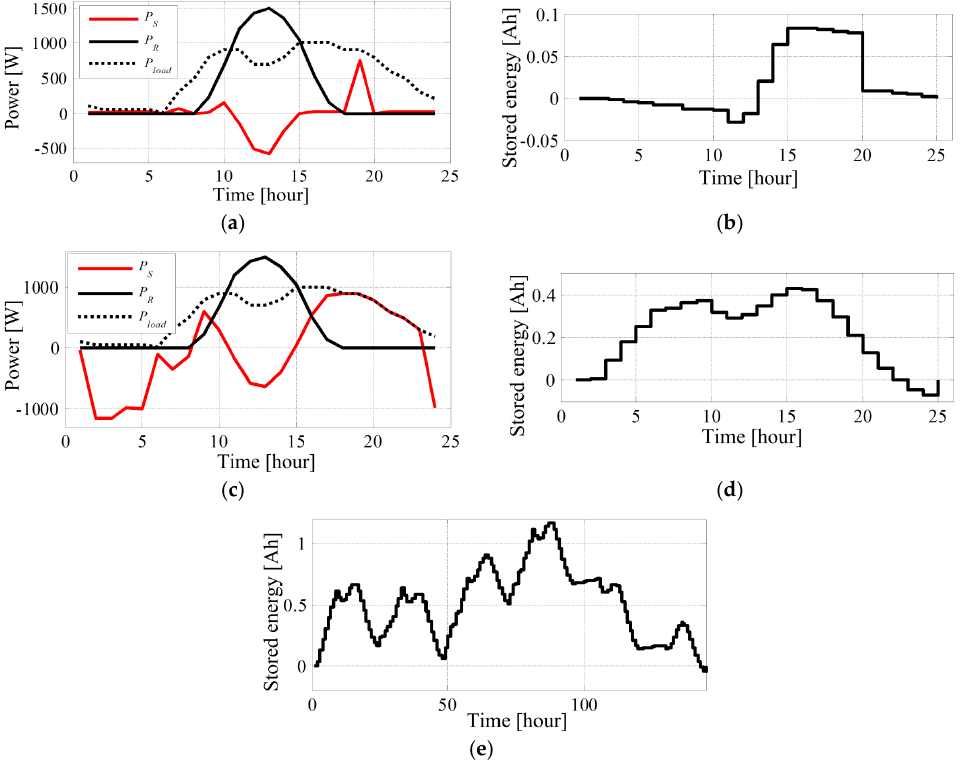
Figure 5. EMS optimization results with various conditions. ( a ) Power profile with fixed price; ( b ) energy profile with fixed price; ( c ) power profile with variable price; ( d ) energy profile with variable price; and ( e ) optimization result of a calculation executed 6 days ahead of time, with variable price.